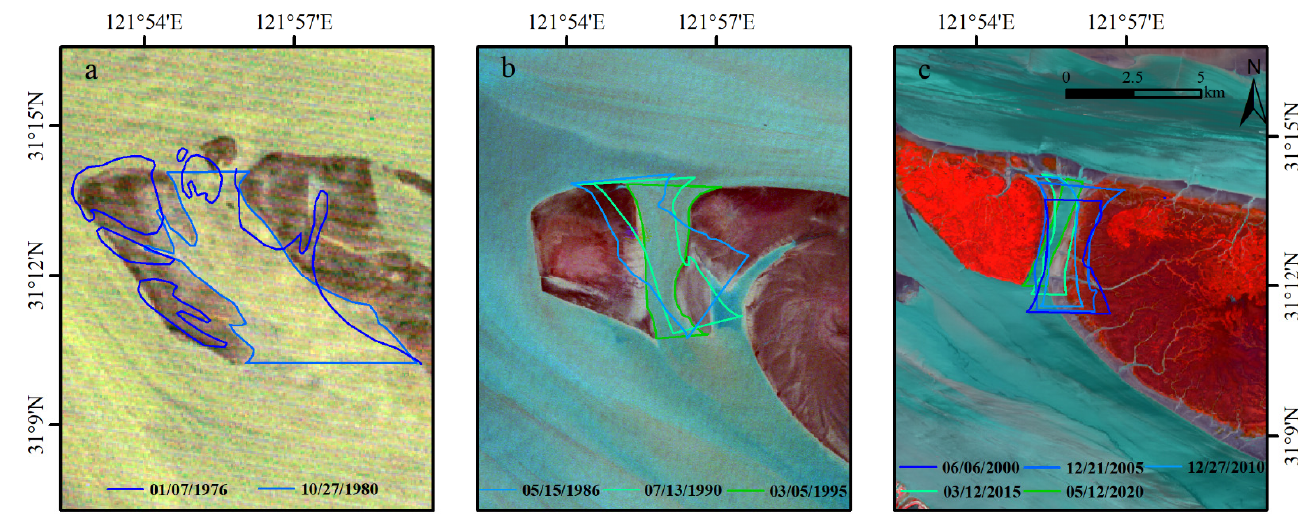
Figure 9. Evolution of the tidal creek between the US and MLS. The underlying image is the Landsat image acquired on ( a ) 27 October 1980, ( b ) 5 March 1995, and ( c ) 12 May 2020, respectively. Erosion was evident on the southern side of the US and MLS. Especially, in the south- west of the US, the initially convex waterline gradually changed to straight and then con- cave (Figures 7 and 9), showing the erosion stage. And the waterlines on the east and west sides of the tidal creek gradually became straight. Moreover, the southern boundary line of the tidal creek moved about 21.32 km northward from 2005 to 2015.